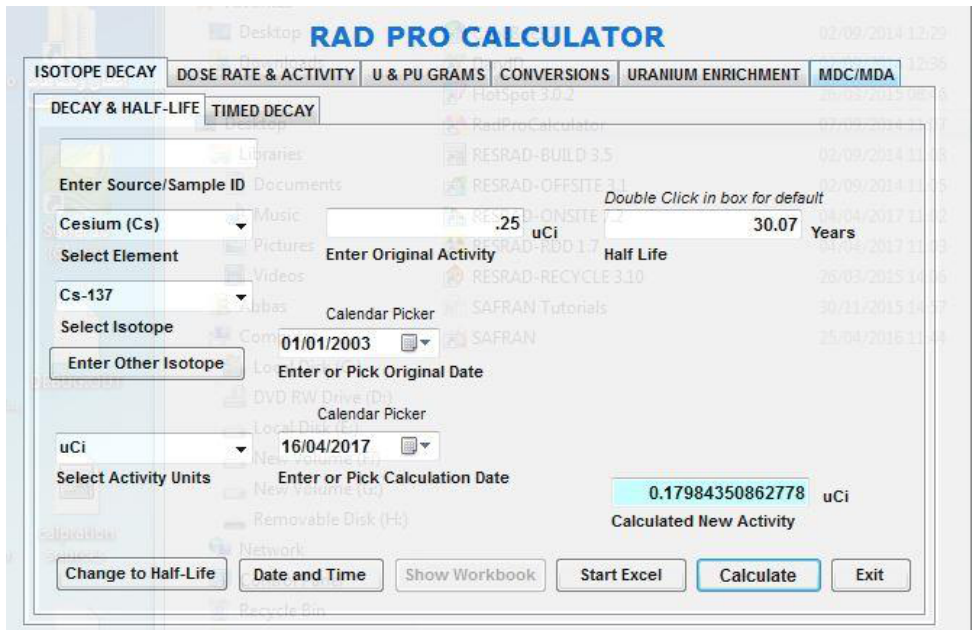
Fig.5: Calculation of current activity for CS-137.